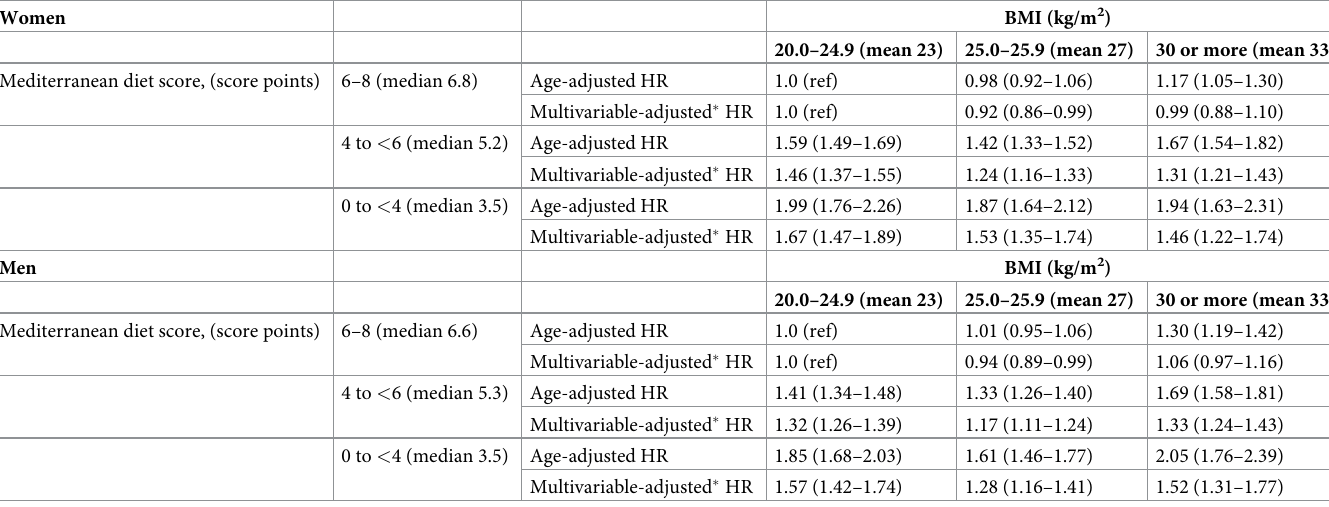
Table 2. Combined associations of a Mediterranean diet score and BMI on all-cause mortality in women and in men. High adherence to a Mediterranean diet and a normal body index is the reference with an HR of 1.0. Women BMI (kg/m 2 ) 20.0–24.9 (mean 23) 25.0–25.9 (mean 27) 30 or more (mean 33) Mediterranean diet score, (score points) 6–8 (median 6.8)